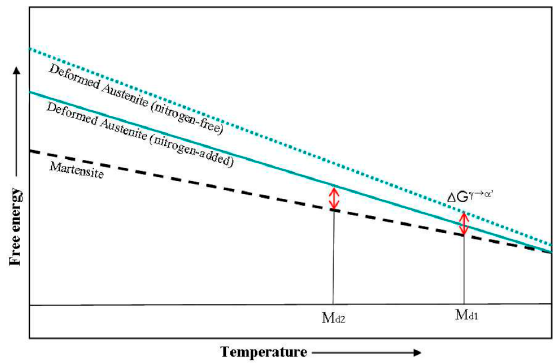
Figure 3. Schematic free energy diagram of deformation induced martensitic transformation (DIMT) at a certain strain level.